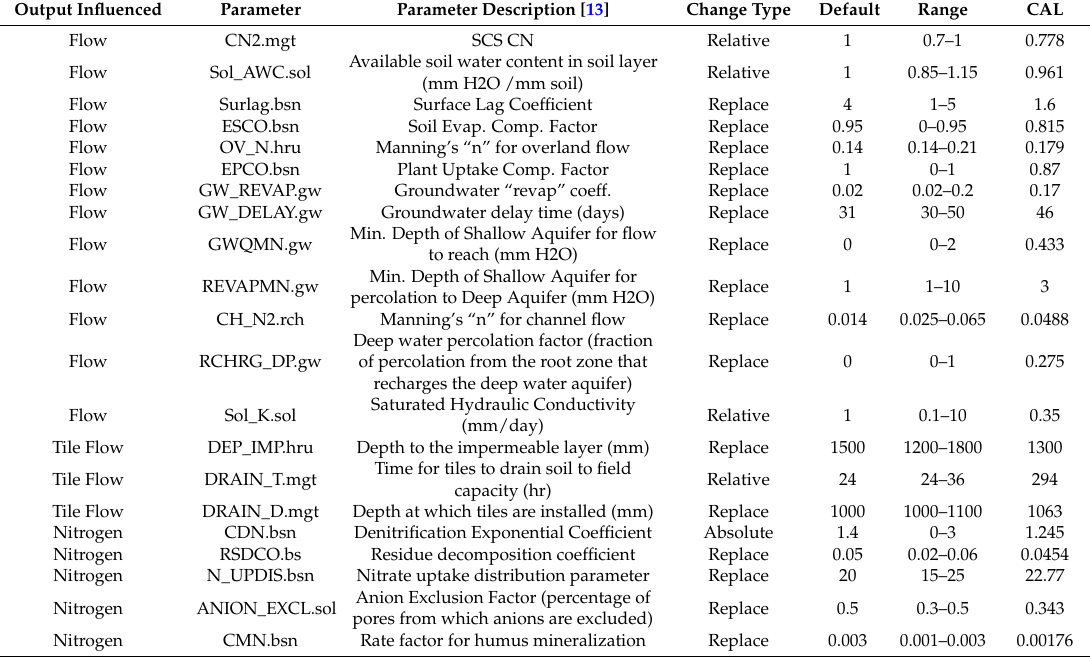
Table 1. Change in parameters for